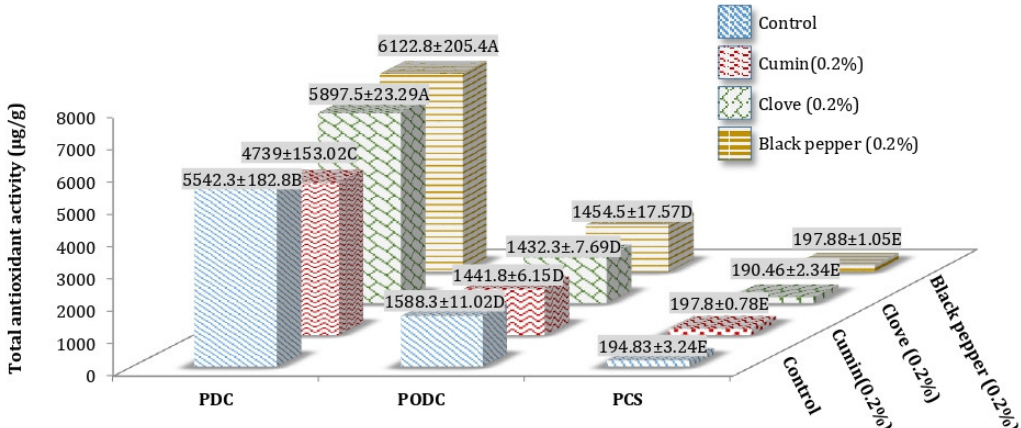
Figure 1. Mean values for Total antioxidant activity (TAA) of processed Cheddar cheese (PCS), orally digested (PODC), and duodenal digested Cheddar cheese (PDC) made from buffalo milk after ripening. A–E means followed by the same letter for the same parameter are not significantly different ( p < 0.05).